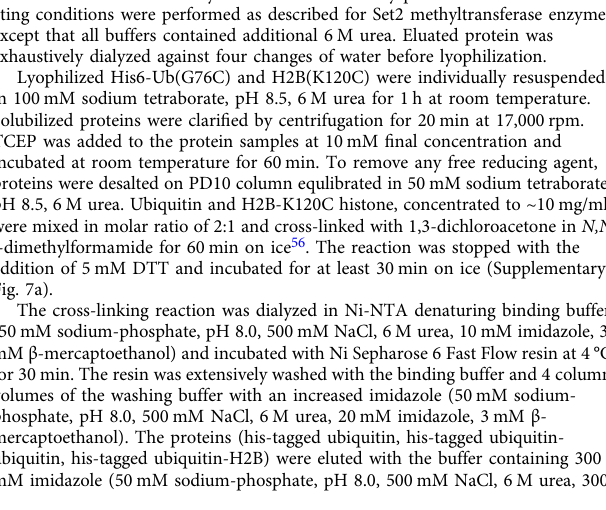
Supplementary Table 1. After ethanol precipitation, the DNA was resuspended in 15 mM HEPES-NaOH pH 7.5, 2M NaCl, 1 mM DTT. The nucleosome reconstitution was done by ‘ double bag ’ dialysis method 48 . The dialysis buttons, containing 0.25 ml of histone octamer:DNA mixture, were